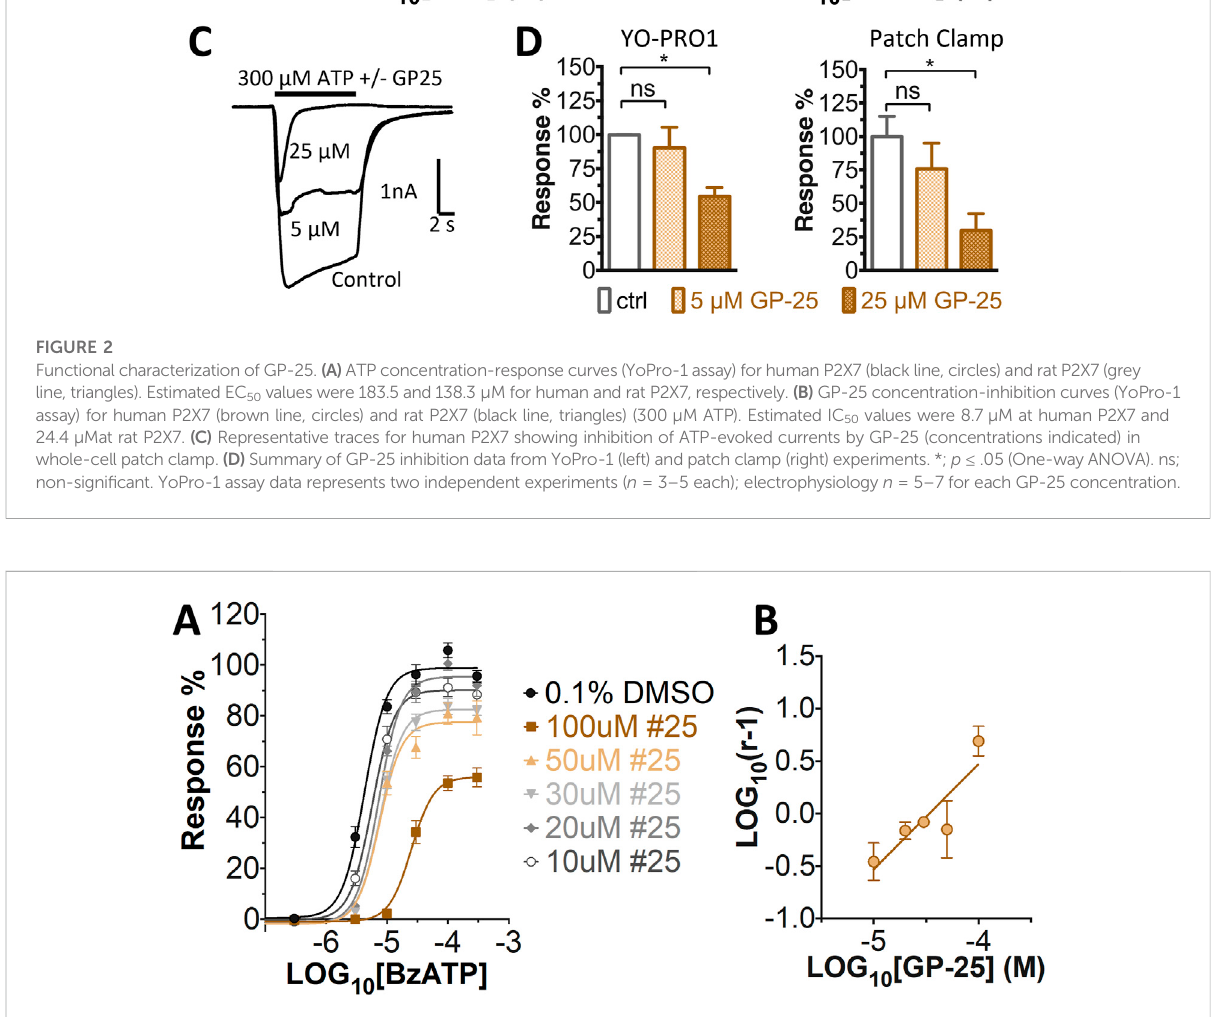
FIGURE 3 GP-25 is an orthosteric P2X7 antagonist. (A) BzATP concentration-response curves in increasing concentrations of GP-25 (compared to control; .1% DMSO). Curves are fi tted without constraints (simple 4-parameter fi tting). (B) Schild plot of the relationship between GP-25 concentration and the dose ratio. The equation for the line of best fi t was Y = 1.004*X + 4.489; R2= .5785. Slope was 1.004 ± .2584; not signi fi cantly different from the theoretical value of 1 at p = .05. Data represents three independent experiments ( n = 3 each).